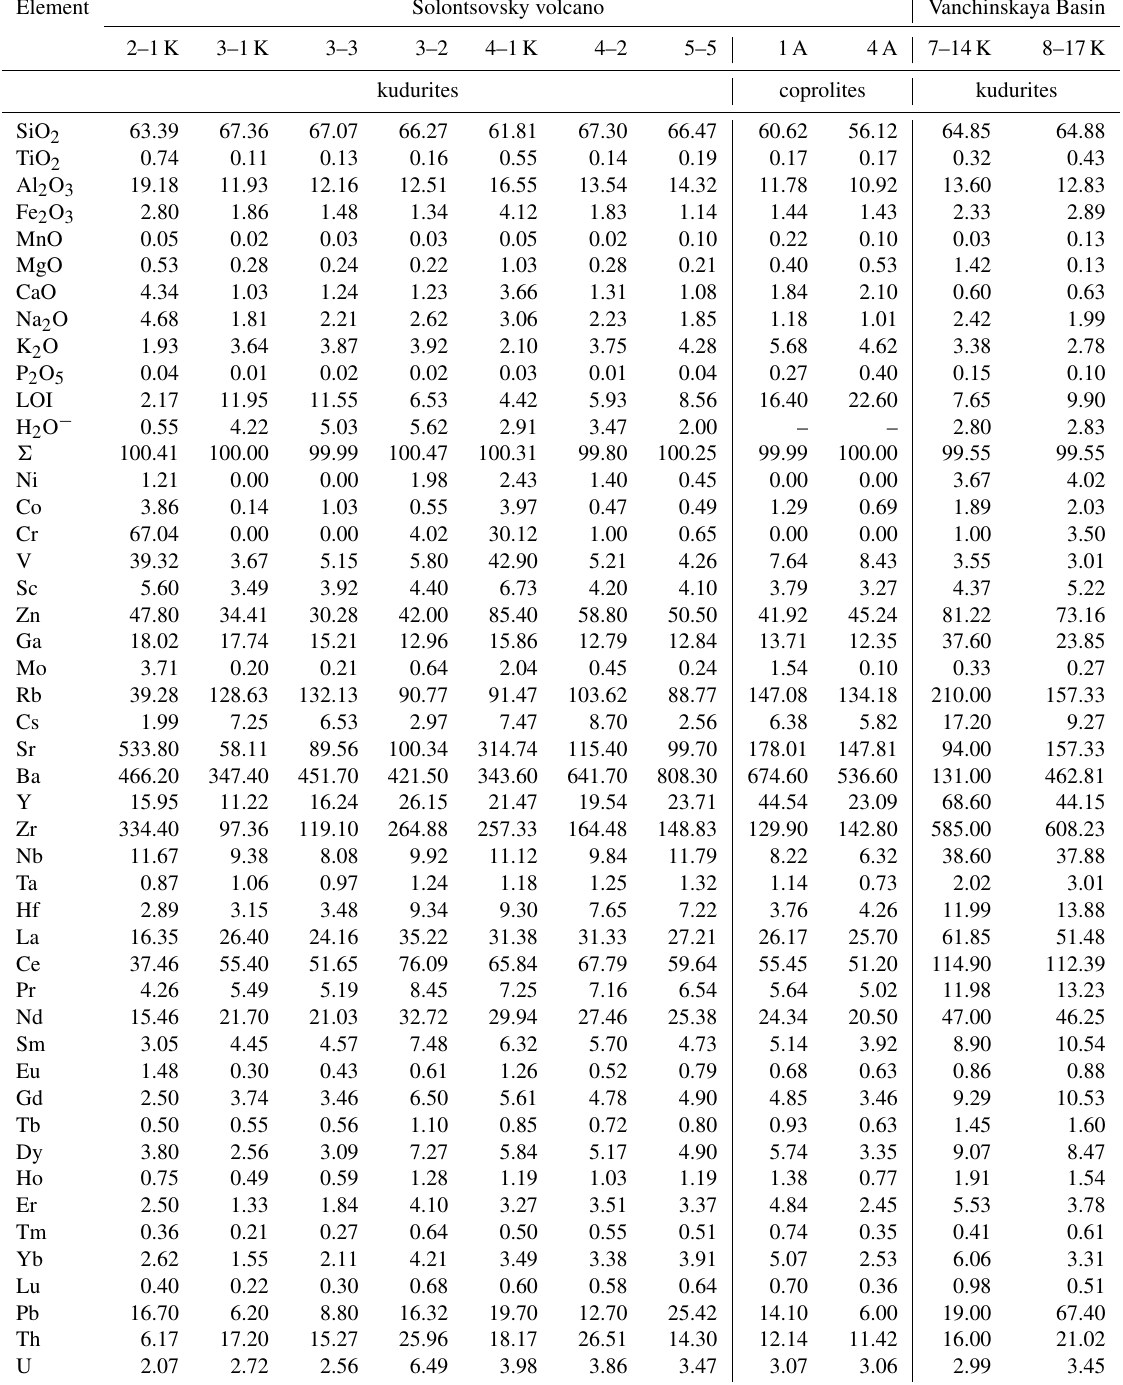
Table 2. Chemical (mass %) and microelement (µgg − 1 ) composition of the studied kudurites’ parent bedrocks and coprolites.